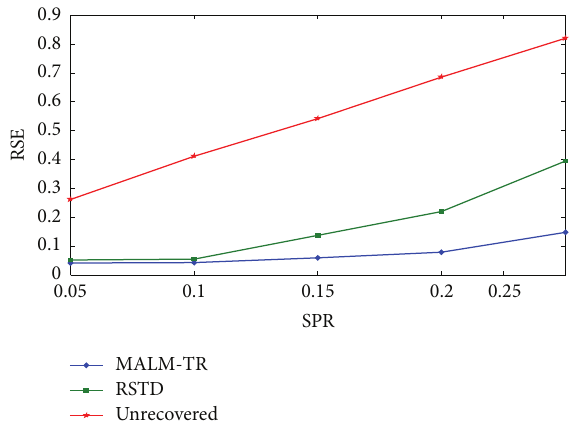
Figure 4: Comparison of RSE curves on traffic